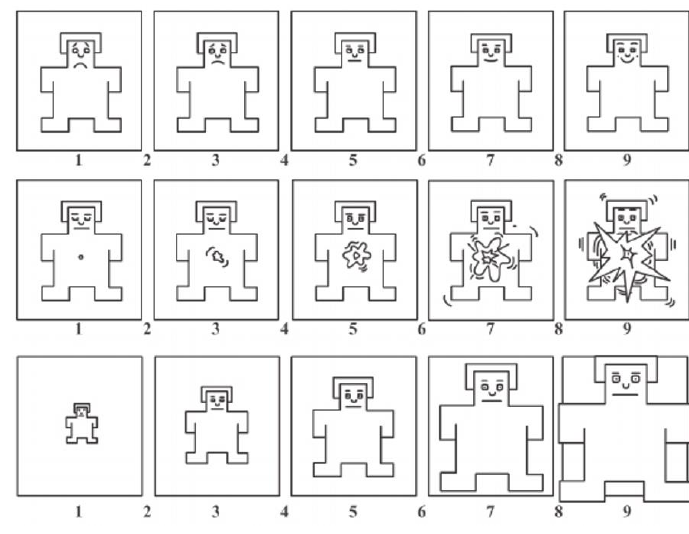
Figure 3. Self-assessment manikin (SAM) scale [24].